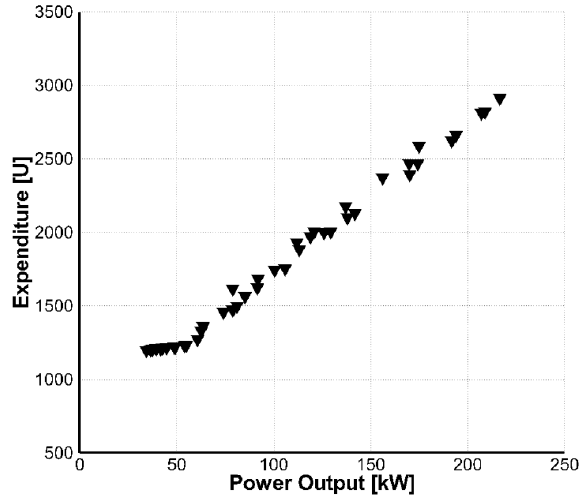
Figure 8. Tradeoff between the expenditure and power output for the Manzanares SCPP. Table 4. Comparison of the design parameters and objective functions between selected solutions of the Pareto set and Manzanares power